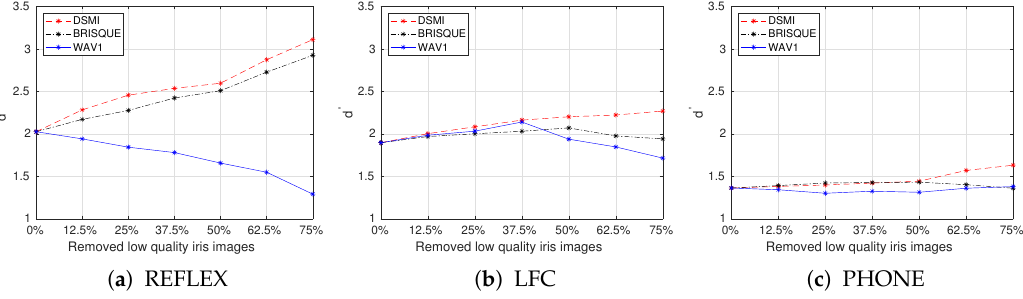
Figure 7. Daugman’s decidability index for all iris images, after filtering different parts of the iris images with the poorest quality using three image quality metrics on three test